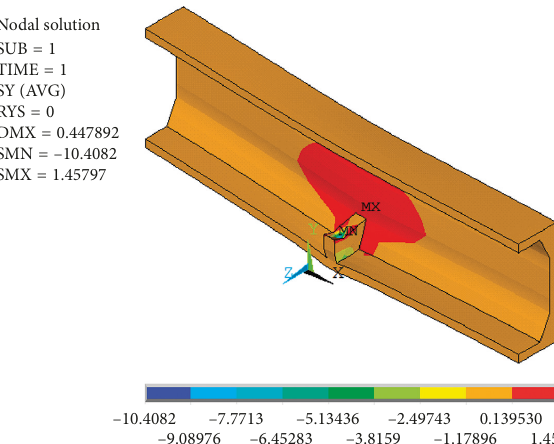
Figure 14: Cross stress distribution in the web of the arch